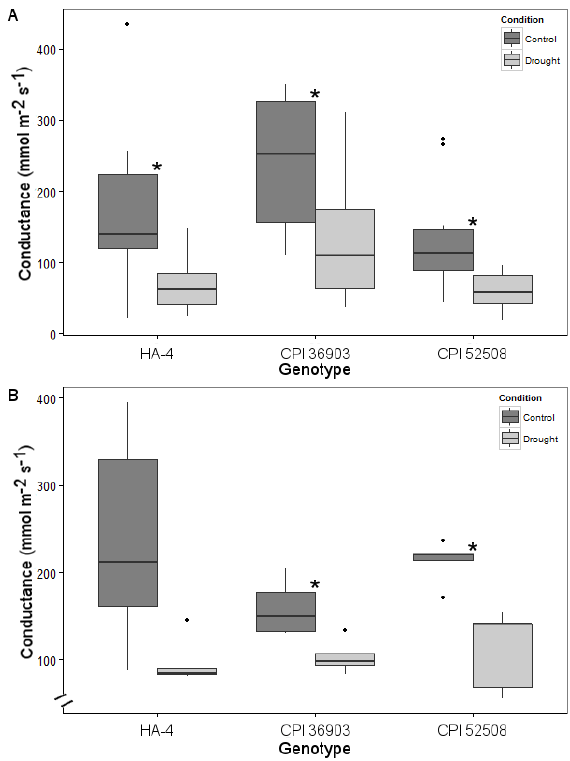
Fig. 3: Effects of water limitation after eight days on stomatal conduc- tance through porometry in mmol m -2 s -1 (A) exp. 1 (n=10) and (B) exp. 2 (n=5); genotypes with * = p